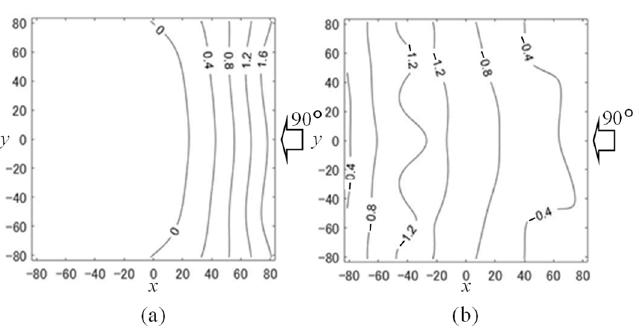
Figure 14. Contours of the maximum and minimum peak wind force coefficients at θ = 60°: ( a ) Maximum; ( b ) minimum.